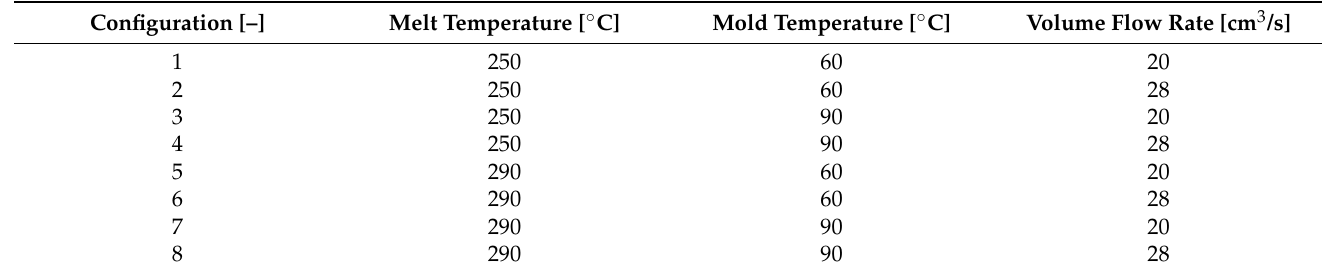
Table 1. Injection molding parameter configurations.